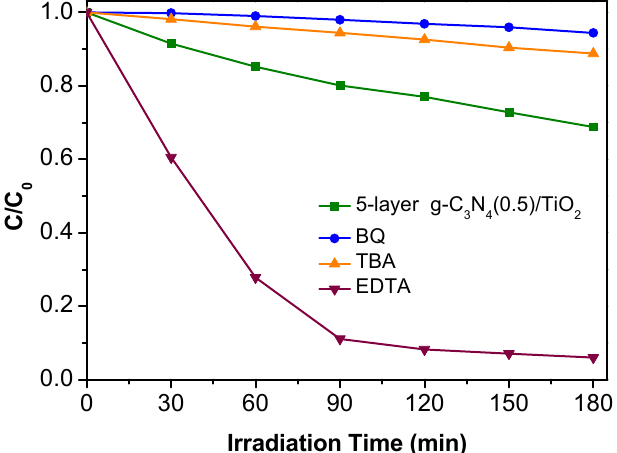
Figure 8. Photodegradation of Rh B over 5-layer g-C 3 N 4 (0.5)/TiO 2 alone and with the addition of benzoquinone (BQ), tert butyl alcohol (TBA), ethylene diamine tetraacetic acid (EDTA).